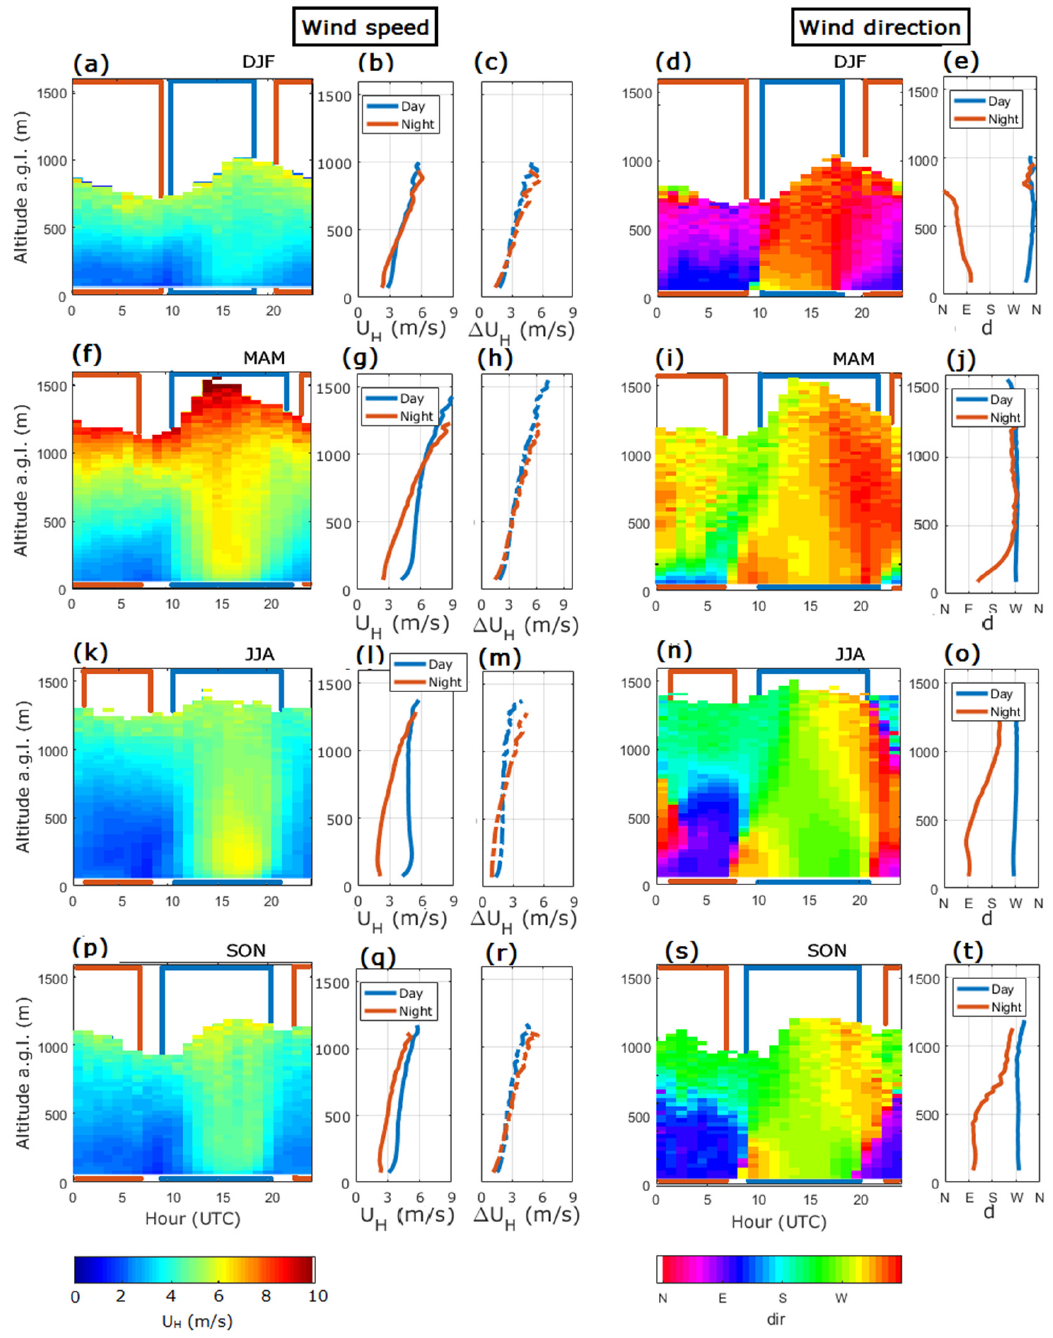
Table 2. Selected hours for ‘Day’ and ‘Night’ time intervals for the averaged profiles at each season.